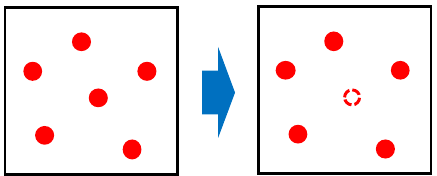
Figure 3. Taking out GNSS data to calculate the weight of the GNSS data.